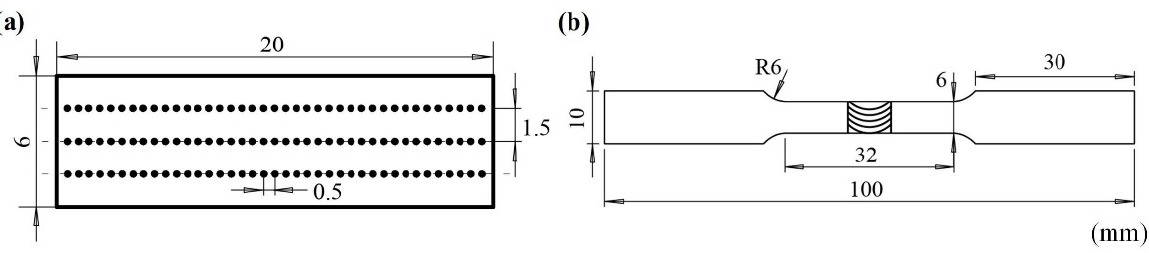
Figure 2. Schematics of ( a ) microhardness test sample and ( b ) tensile test sample.